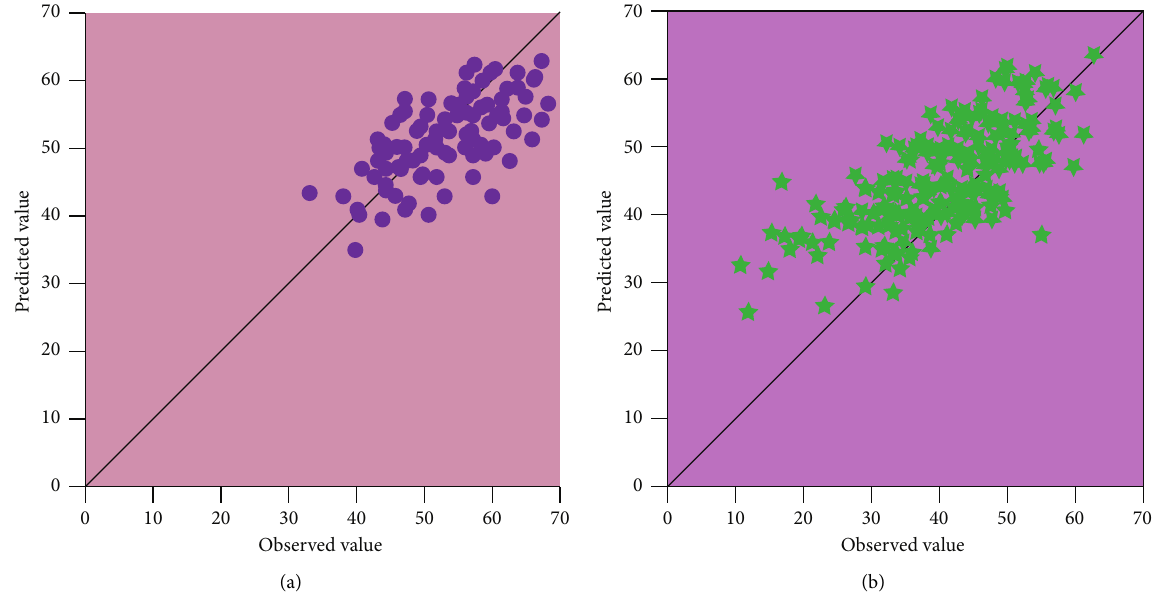
Figure 7: Prediction results of: (a) sample test set and (b) sample training set.